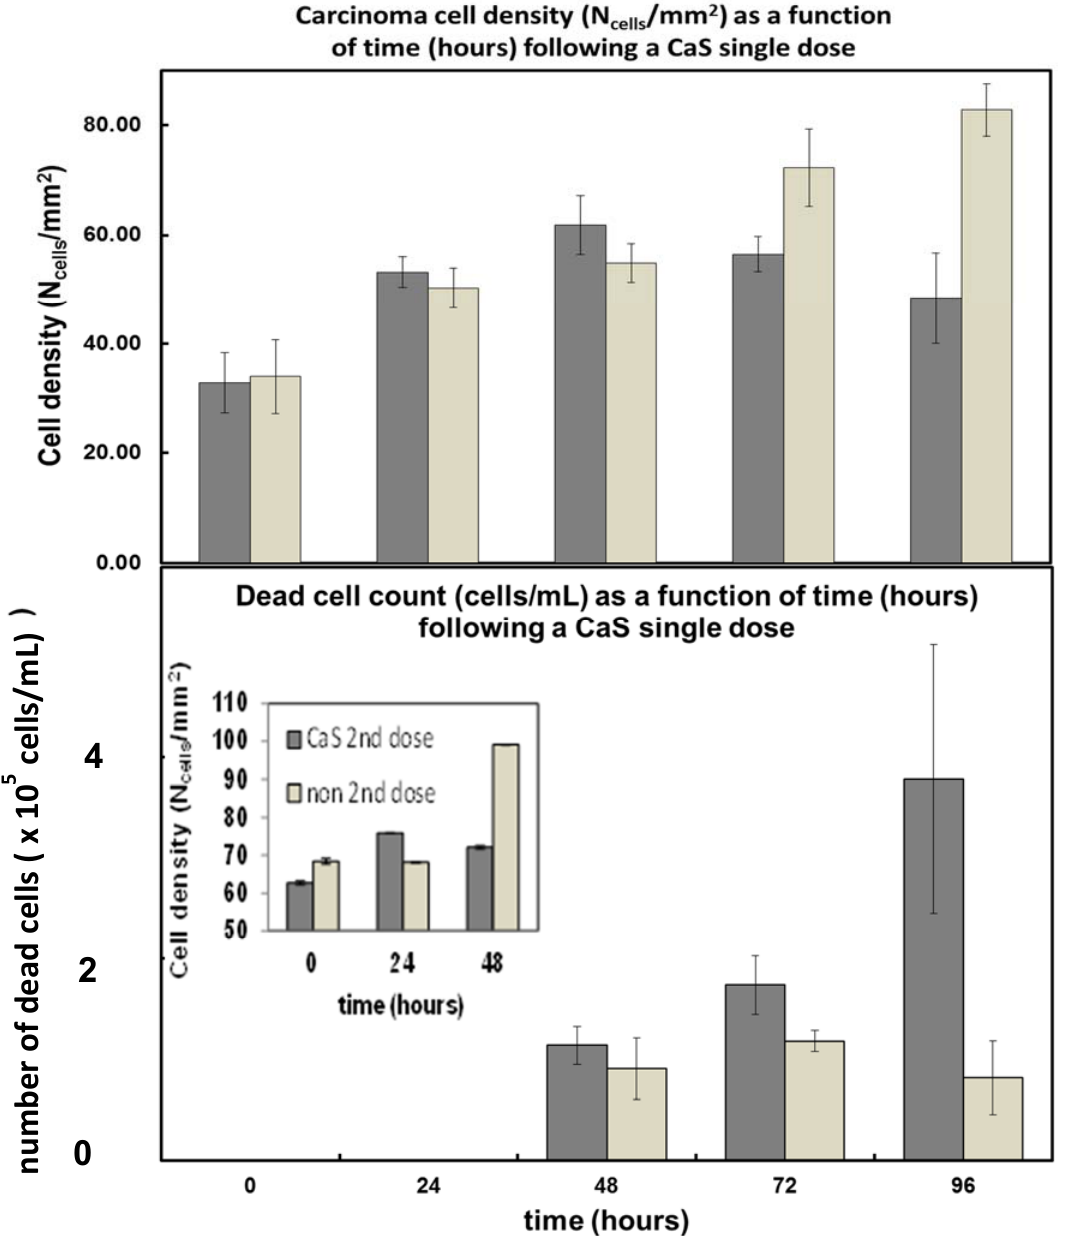
Figure 6. The gray bars in the upper and lower panel summarize the effect of a single dose of CaS NS on the density of carcinoma cells and the number of dead carcinoma cells, respectively, as a function of time. The light gray bars in the upper and lower panel represent the density of adenocarcinoma cells and number of dead carcinoma cells in cell cultures fed with media not containing the CaS nanostructures, respectively. The values reported represent the average of 15 measurements performed on different regions of three different flasks. The error bars represent the standard error of the measurements. The dark and light gray bars in the insert represent the dependence of the density of adenocarcinoma cells exposed to a second dose of the CaS NS and exposed to one dose, respectively, on time. The time t = 0 h is taken to correspond to the time of the initial dose. The total mol of Ca 2+ in the NS dispersion is 4 × 10 − 8